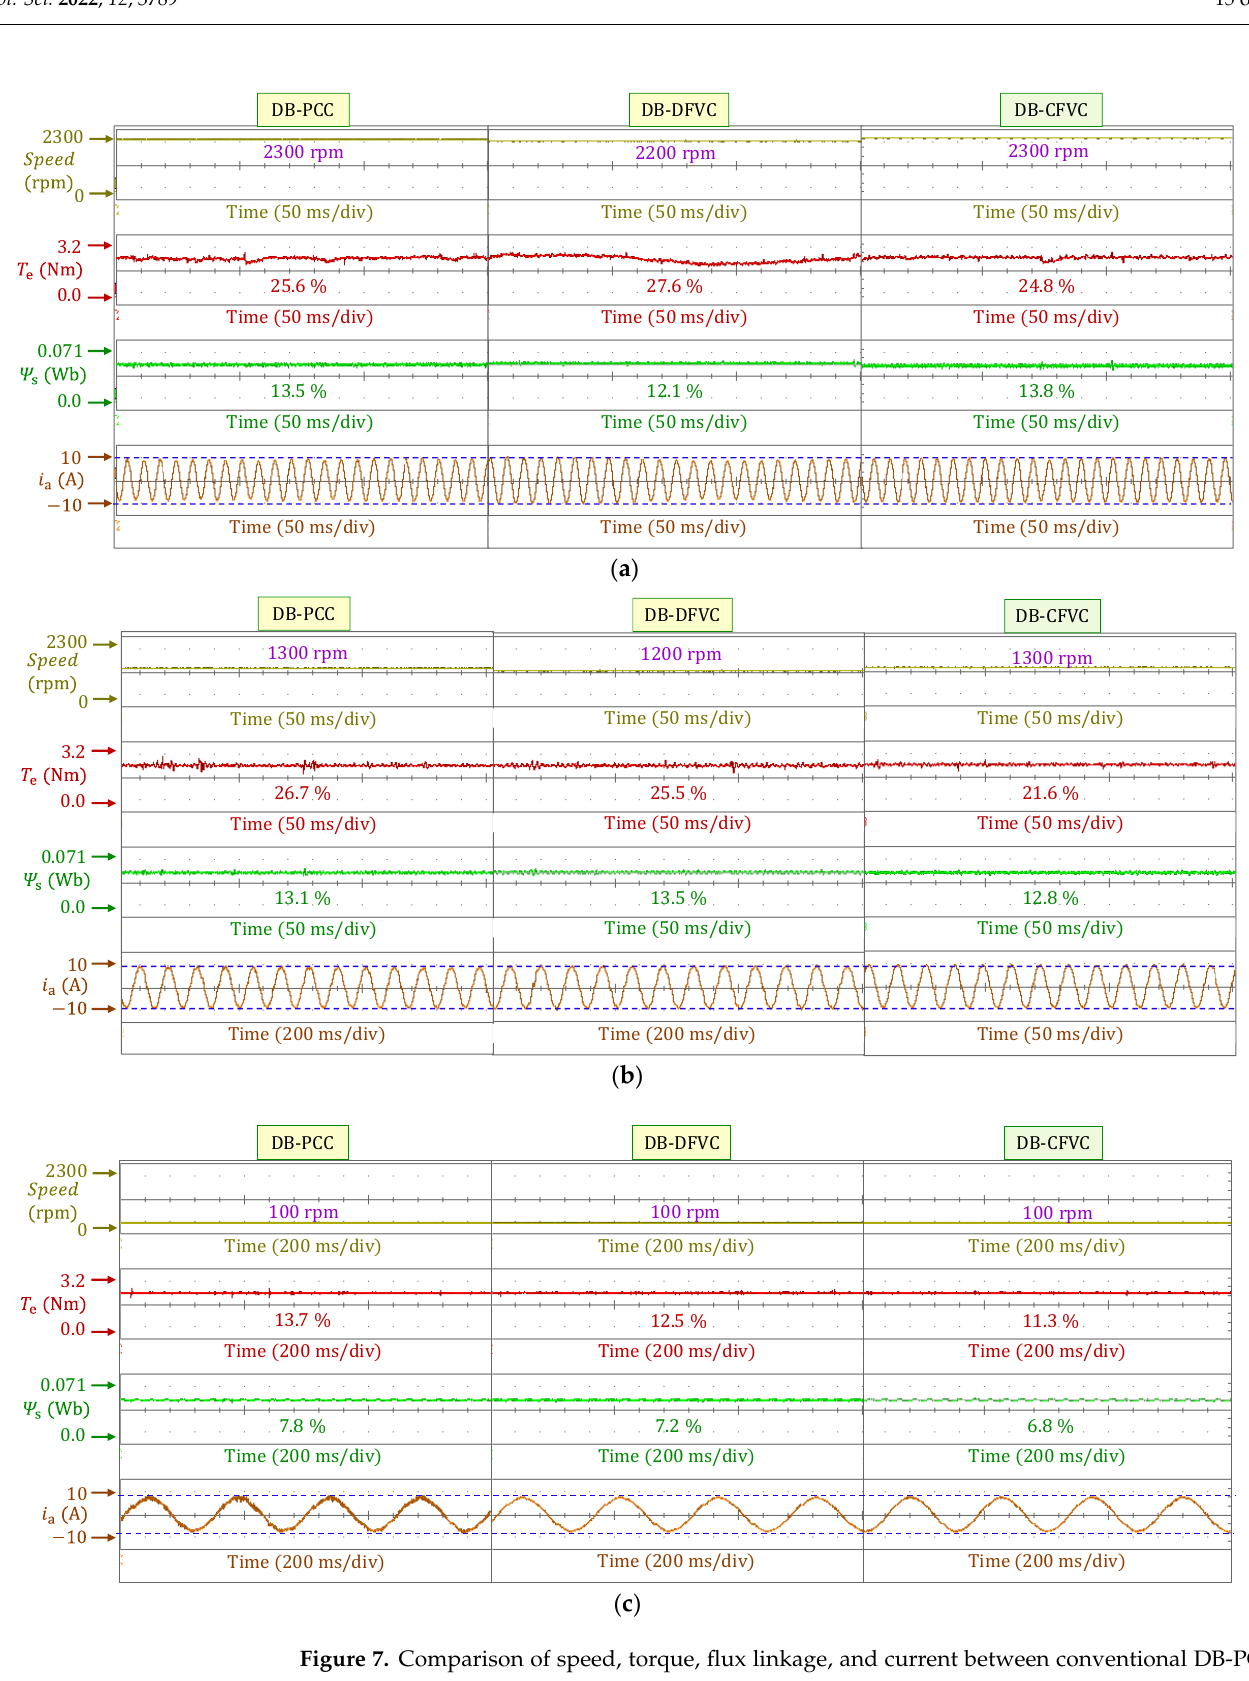
Figure 6. Experiment results of dynamic performance comparison between DB-PCC, DB-DFVC, and proposed DB-CFVC: ( a ) comparison of response time as sped up to 2300 rpm at load torque 2.5 Nm; ( b ) zoom-in at the points ( 1 – 3 ) in ( a ) to analyze voltage command waveforms.